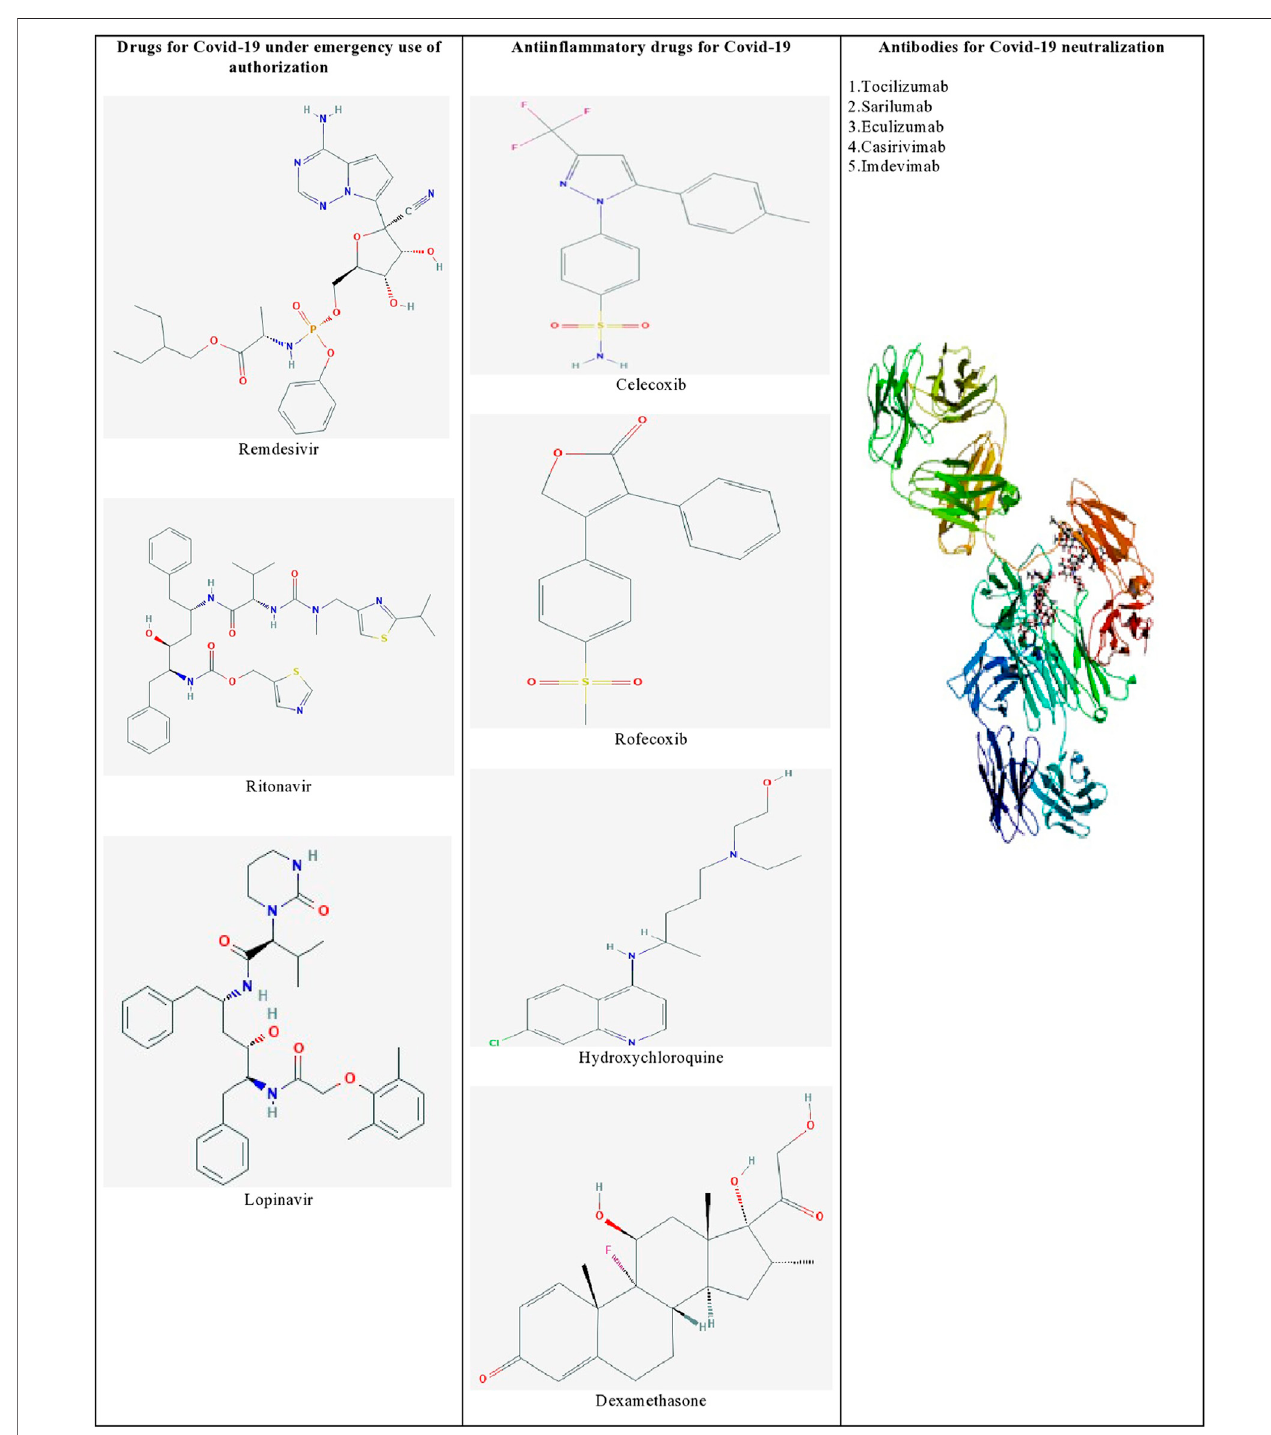
FIGURE 1 | List of promising therapeutic candidates for SARS-CoV-2 infection. Remdesivir, ritonavir, and lopinavir were employed under emergency use of authorization. Anti-in fl ammatory drugs such as dexamethasone, hydroxychloroquine, rofecoxib were used to manage in fl ammatory responses during SARS-CoV-2 infection. Humanized monoclonal antibodies such as tocilizumab, sarilumab, eculizumab, casirivimab, and imdevimab were found to be effective against SARS-CoV-2 induced pneumonia.